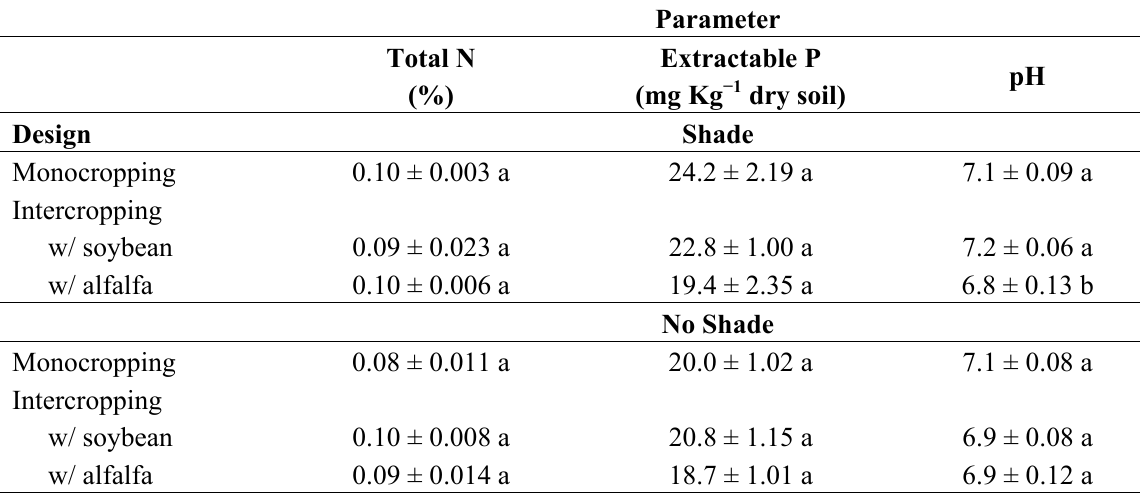
Table 3. Soils status from rhizobox soils. Data are means (±SE) for three